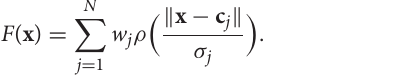
suggested to make use of a radial basis function (RBF) network, while representing the model’s target outputs as F HNN ( x ) = µ 1 F BP ( x ) + µ 2 F RBF ( x ) with µ 1 and µ 2 being mixing coefficients. It is suggested to use a genetic algorithm (Gandomi and Roke, 2015) for training the